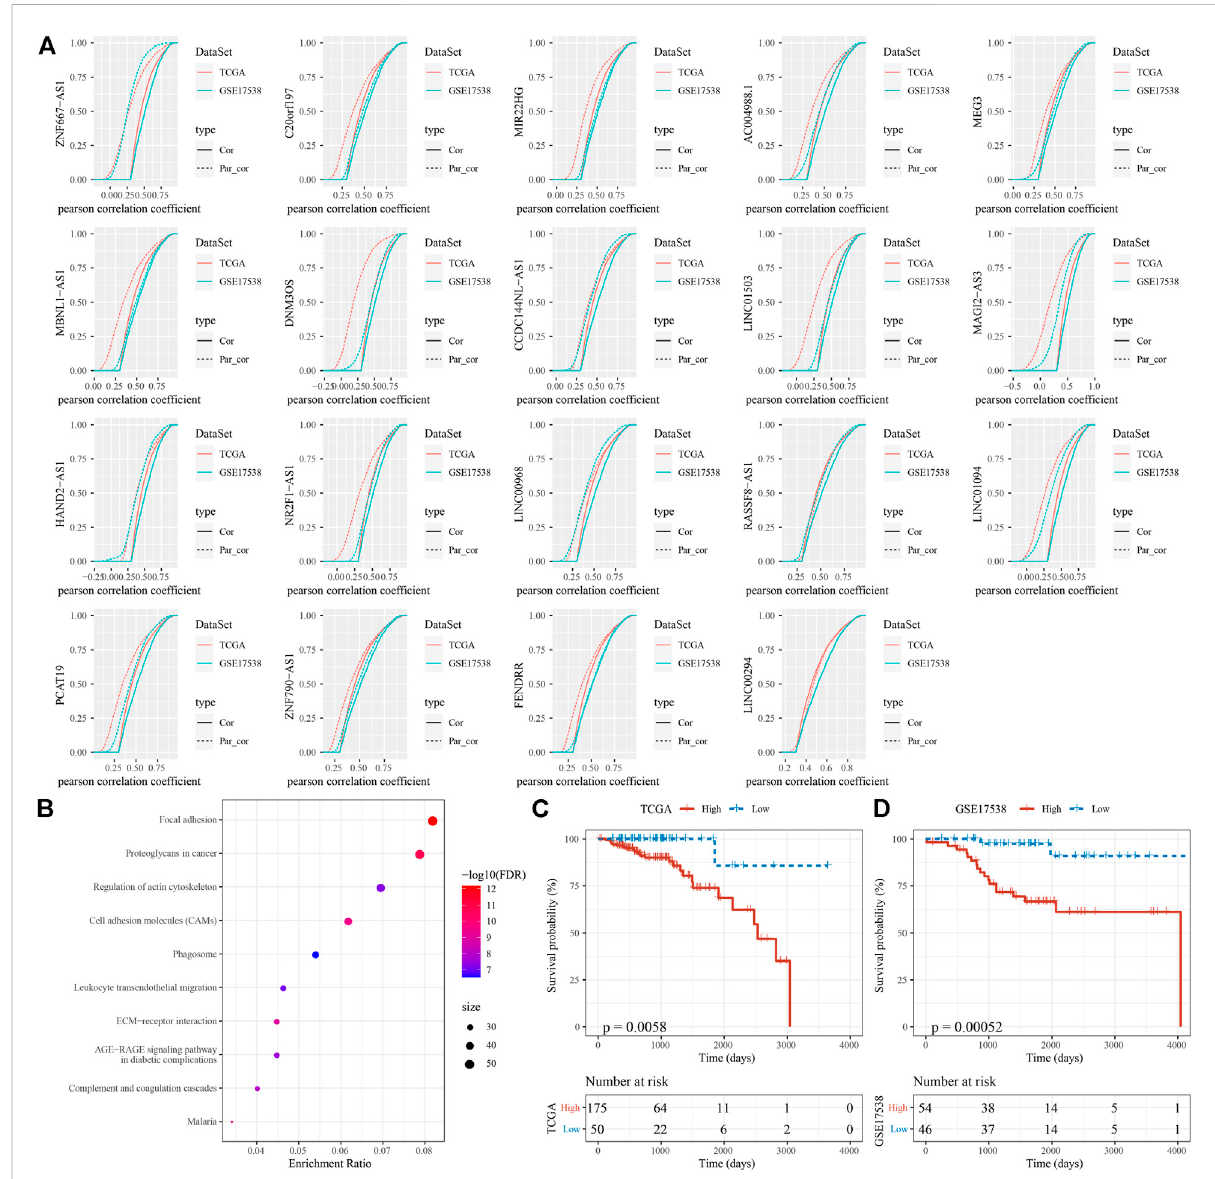
FIGURE 8 Identi fi cation of key EMT-related lncRNAs (A) First order partial correlation analysis on the 19 identi fi ed EMT-related lncRNAs with EMT score and EMT-related genes. Four CDF curves werepresented. Solid and dashed lines represents CDF ofcorrelationcoef fi cients betweenEMTscore and EMT-related genes, without and with adjustment respectively. Kolmogorov-Smirnov test was performed between solid and dashed lines. Vertical axisindicatescumulativeprobabilities. (B) GSEAonEMT-relatedgenesassociatedwiththe6EMT-relatedlncRNAs. (C – D) Kaplan-Meiersurvival analysis of high-risk and low-risk groups strati fi ed by the 6-gene prognostic model in two cohorts. Log-rank test was